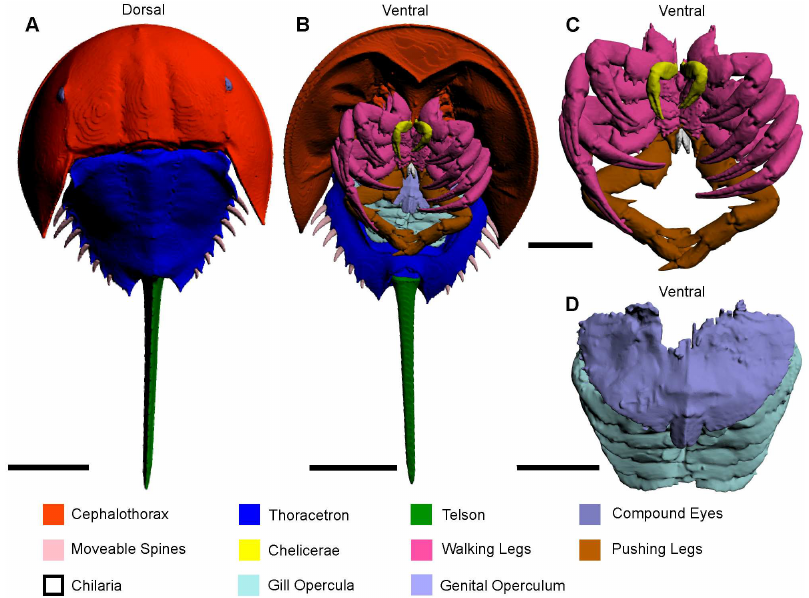
Fig 1. 3D reconstruction of the complete museum specimen (va.06) of Limulus polyphemus in dorsal and ventral aspect, as modelled from CT scanning. (A) Dorsal view of entire exoskeleton. (B) Ventral view of entire exoskeleton. (C) Detail of cephalothoracic appendages. (D) Detail of thoracetronic appendages. The interactive 3D version of this file is available in the Supporting Information (S1 Fig). Scale bars 100 mm for A, B; 50 mm for C, D.